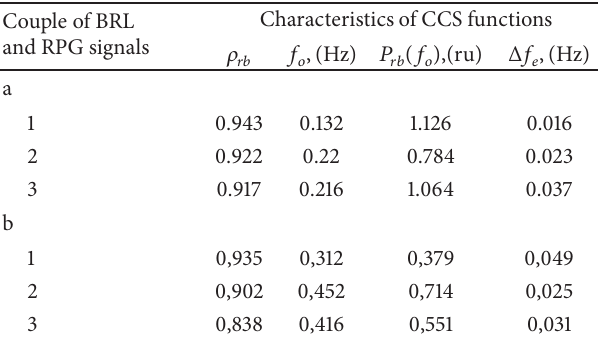
Figure 5: Typical NCCFs for couples of BRL and RPG signals ((a): spontaneous breathing; (b): rapid breathing). Table 1: Generalized characteristics of CCS